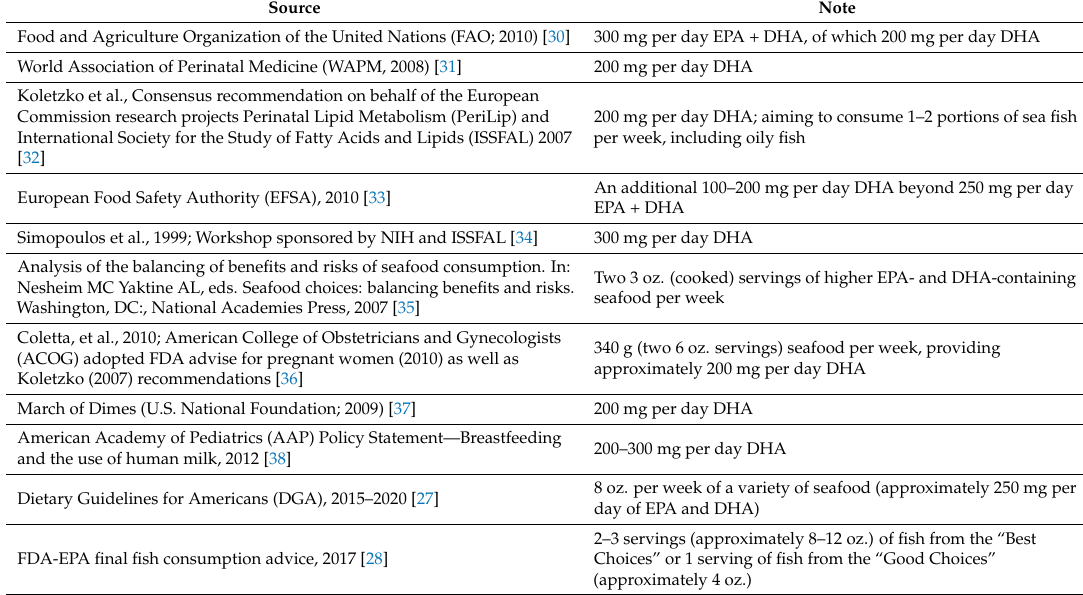
Table 1. EPA and DHA worldwide recommendations for pregnant and lactating